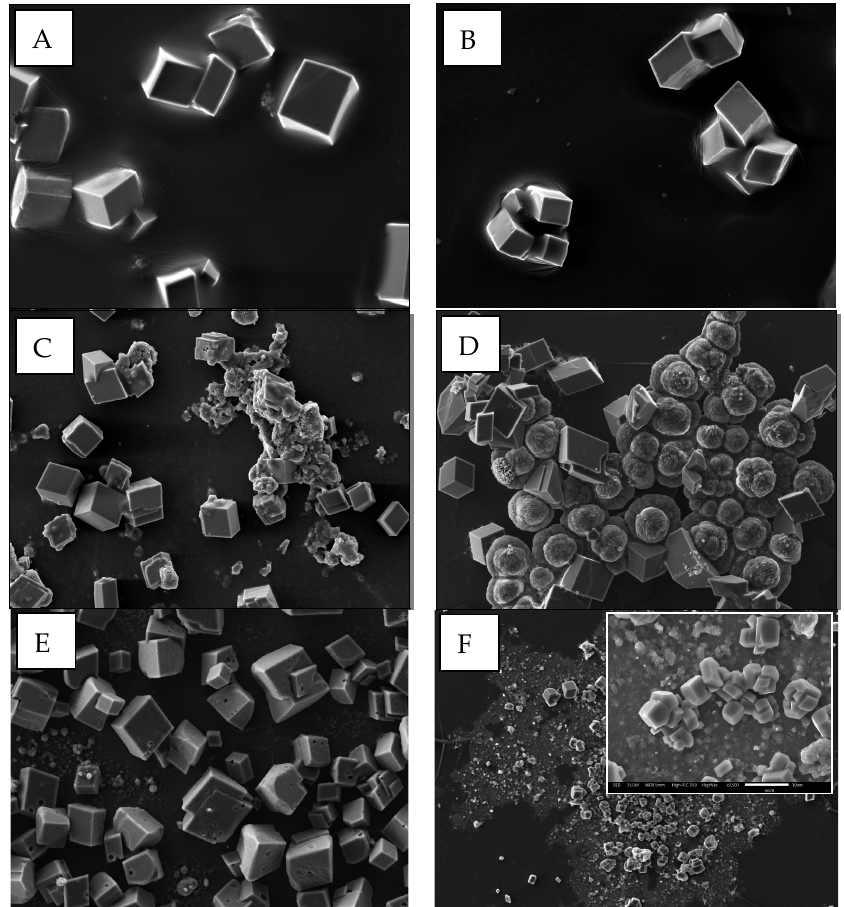
Figure 1. SEM images of CaCO 3 crystals obtained by using GD crystallization. Control ( A ), ALG Les ( B ) MWCNT ( C ), MWCNT-OX ( D ), ALG Les /MWCNT ( E ) and ALG Les /MWCNT-OX ( F ). Scale bar = 50 μ m. Inset scale bar = 10 μ m.